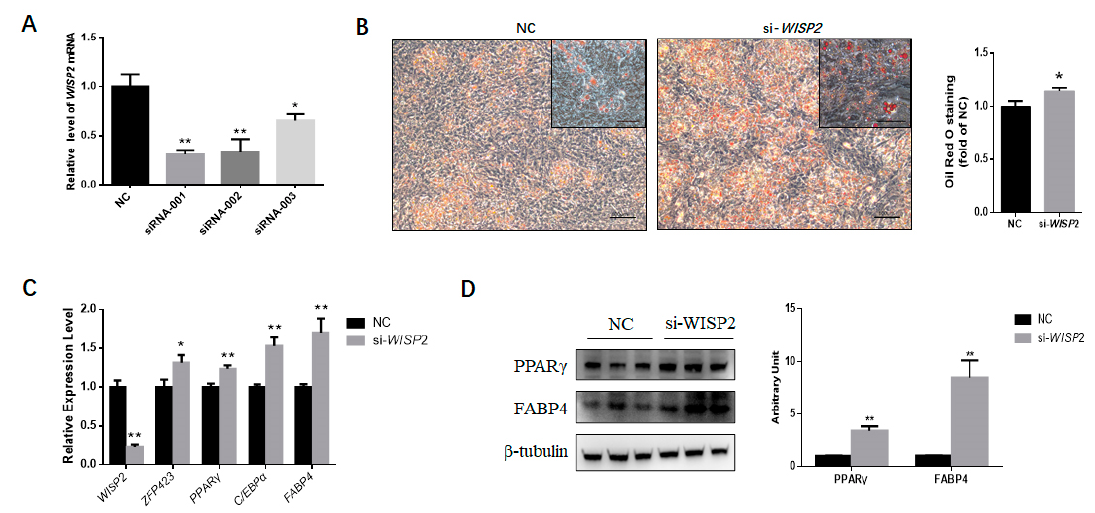
Figure 6. WISP2 silencing promotes the adipogenic di ff erentiation of PDGFR α + cells. ( A ) The interference e ffi ciency of siRNAs targeting WISP2 . ( B ) The accumulation of lipids was analyzed by the Oil Red O staining of di ff erentiated PDGFR α + cells transfected with NC or siRNAs. Scale bar = 100 µ m. The quantification of the stained lipid droplets was performed using the eluted ORO stain via measuring the absorbance. ( C ) Relative expression of adipocyte-specific genes on Day 9. ( D ) Representative Western blot results showing PPAR γ and FABP4 expression in PDGFR α + cells treated with NC or si- WISP2 ; the grayscale intensity was quantified. All the measurements shown are the means ± SEM of four biological replicates from independent cell experiments. NC, negative control. * p < 0.05; ** p <